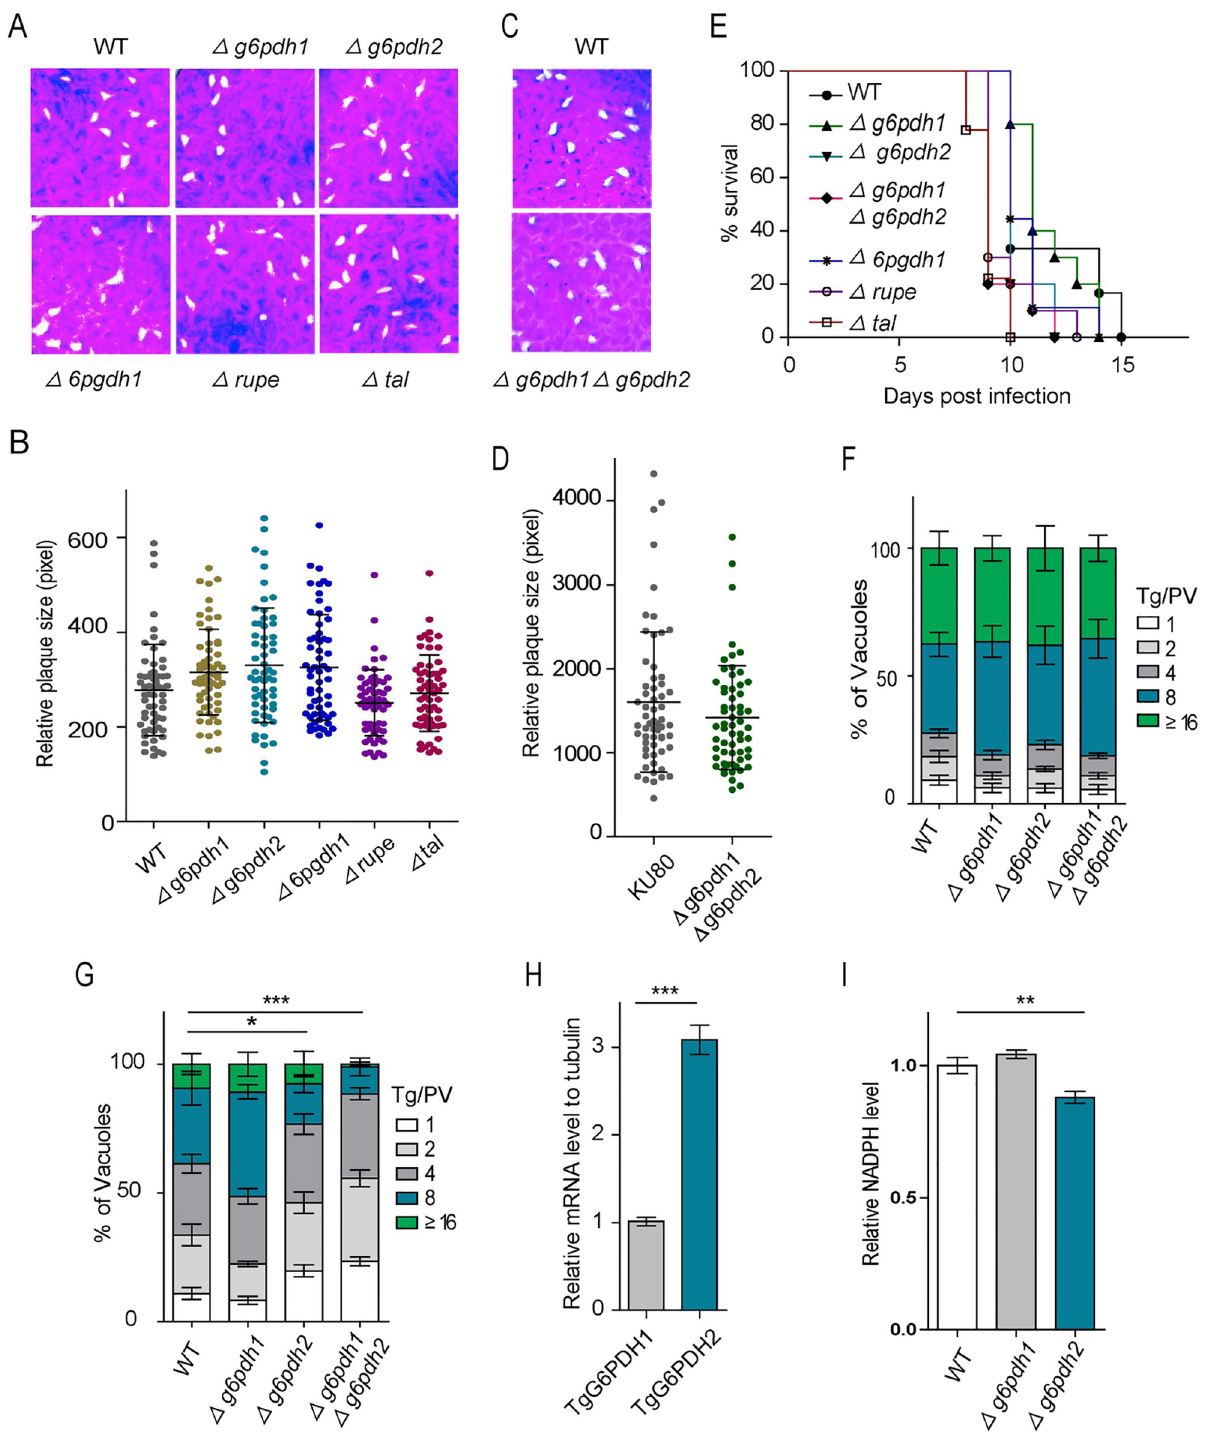
Fig 2. Tg G6PDH1, Tg G6PDH2, Tg 6PGDH1, Tg RuPE and Tg TAL are dispensable for parasite growth and virulence, while Tg G6PDHs are required for defending against oxidative stress. (A) , Plaque assay comparing the growth of Δ g6pdh1 , Δ g6pdh2 , Δ 6pgdh1 , Δ rupe and Δ tal tachyzoites in vitro to that of wild-type strain RH Δ ku80 . (B) , Relative sizes (pixel size calculated by photoshop) of plaques. Means ± SD of > 60 plaques (n = 3). (C) , Representative Plaques image showing the comparative growth of Δ g6pdh1 Δ g6pdh2 and RH Δ ku80 strains. (D) , Graph presentation of plaque sizes